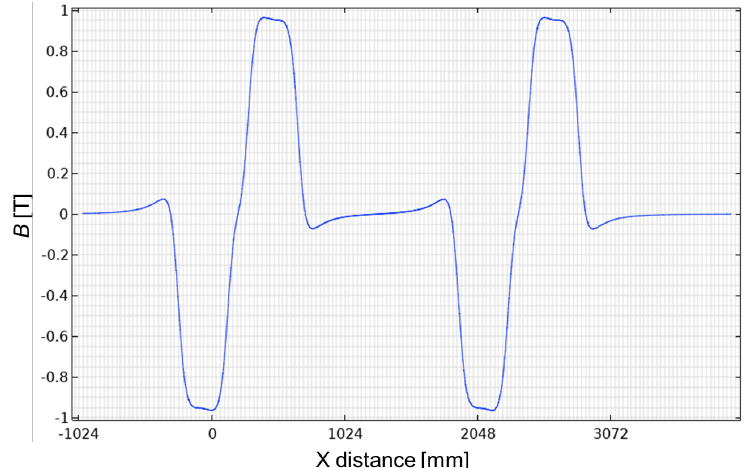
Figure 5. Axial B distribution on the central line of the figure-eight-shaped coils’ surface.